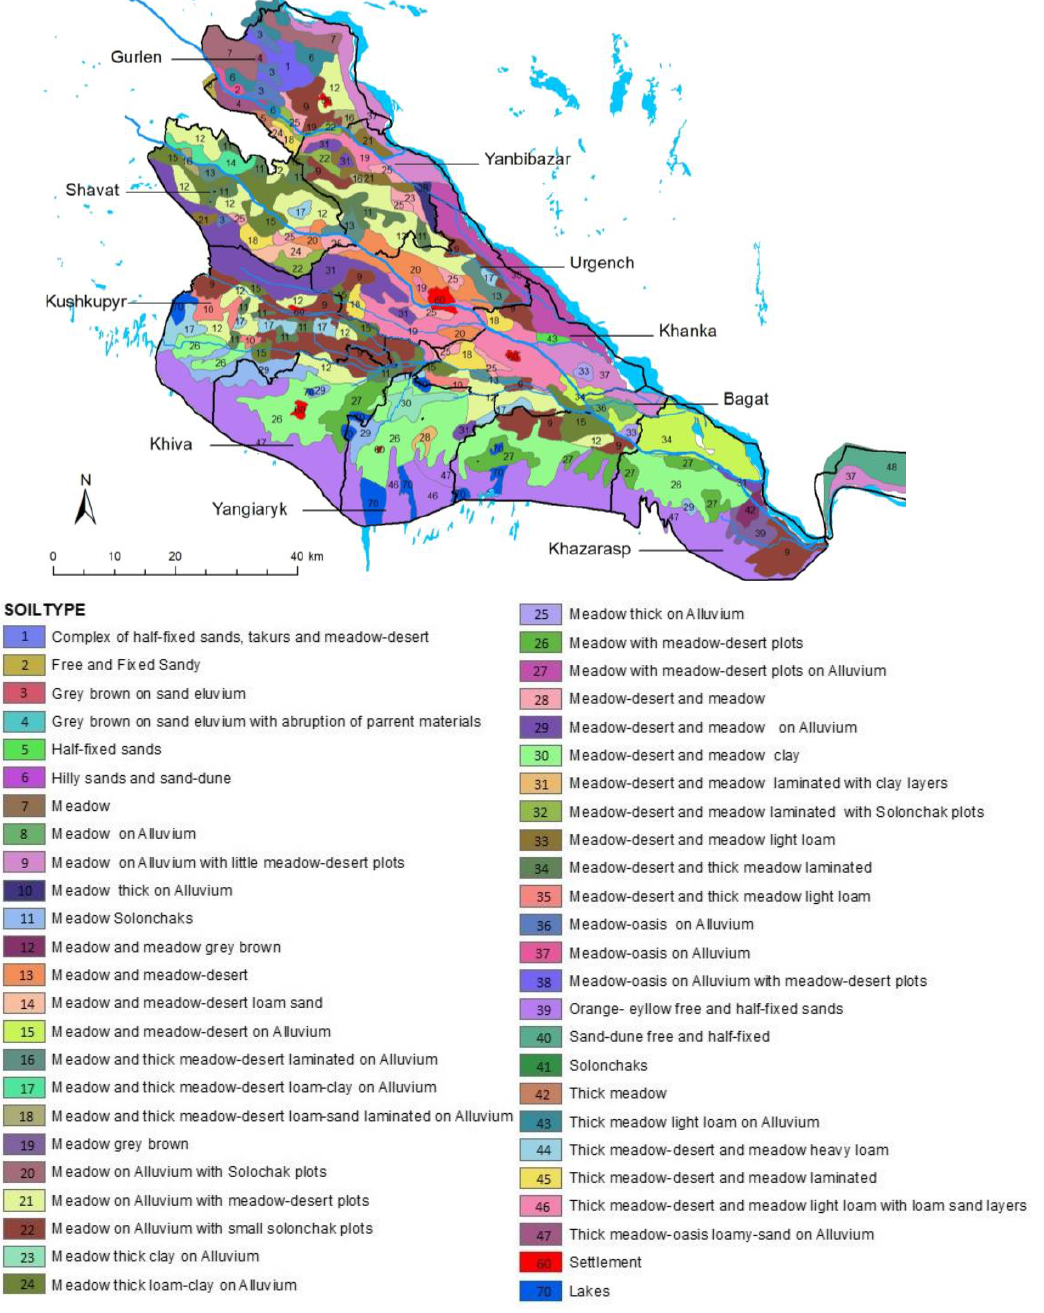
Figure 5. Soil types for the 0–150 cm profile shown for administrative districts of Khorezm, Uzbekistan (scale: 1:100,000). Source: [46] .